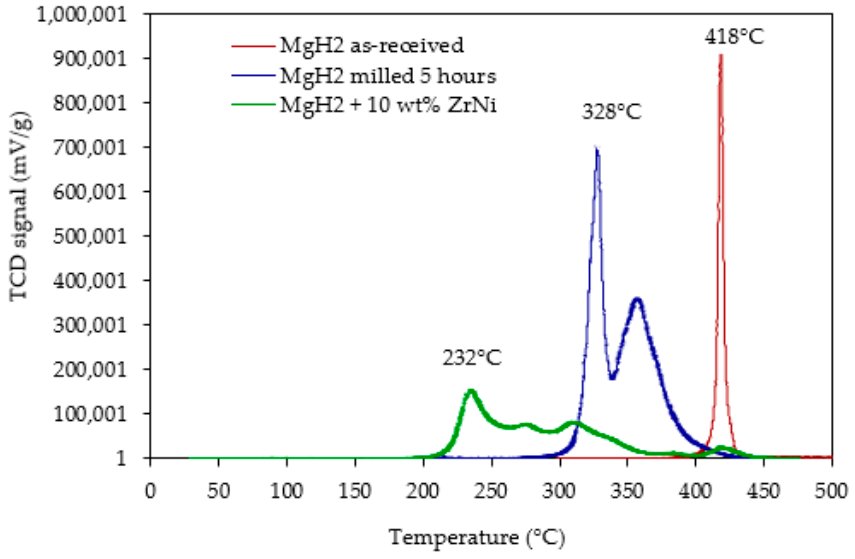
Figure 3. The evolution of the temperature-programmed desorption (TPD) profile of as-received MgH 2 after milling without/with 10 wt.% Zr (x) Ni (y) . Experimental conditions: from ambient temperature to 500 ◦ C under an argon flow of 20 mL min − 1 and at a heating rate of 2 ◦ C min − 1 .